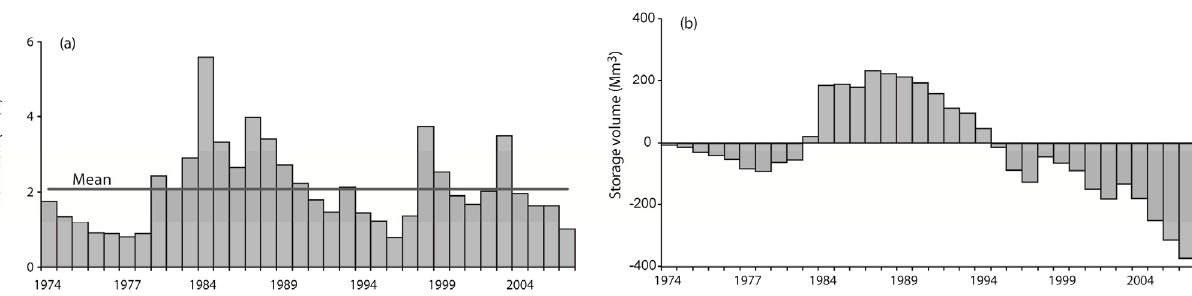
Figure 3. Estimated water balance in the Copiapó River basin. ( a ) Water